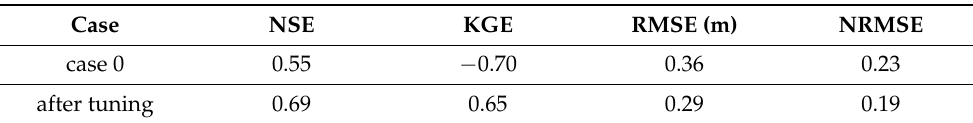
Table 2. Comparisons of performance metrics, NSE, KGE, RMSE and NRMSE, of the computed results before and after the auto-tuning. Case NSE KGE RMSE (m) case 0 0.55 0.69 0.65